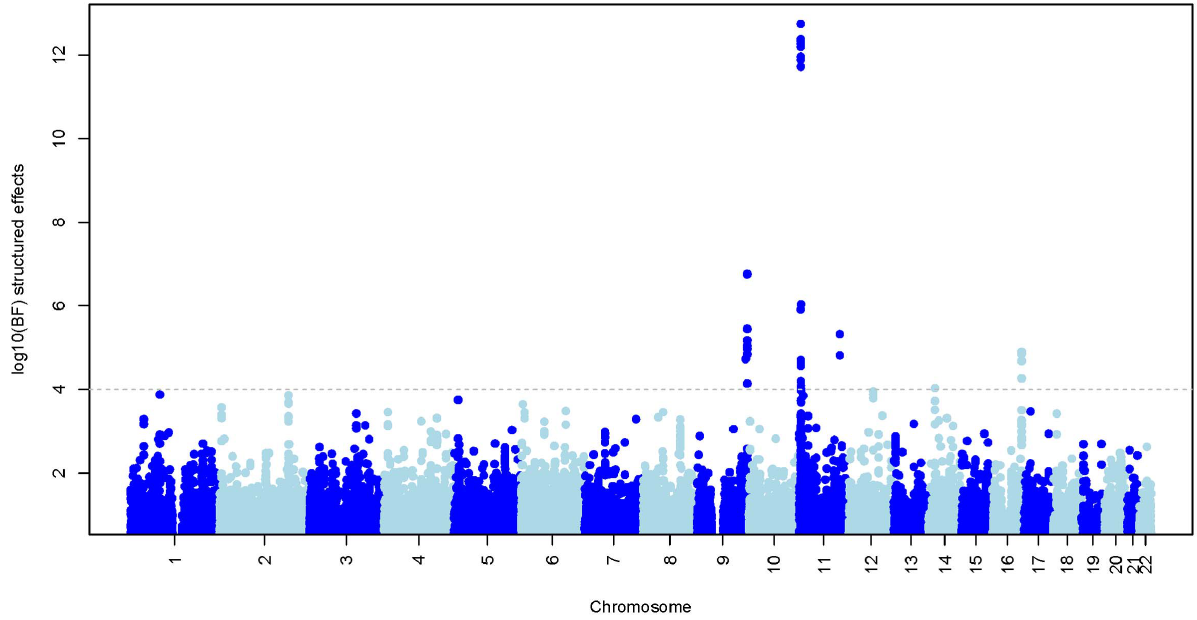
Figure 5. Evidence for association at approximately 1.3M autosomal SNPs. The plot shows the log10 Bayes factor comparing the structured effects model (model 4; see main text) to a model of no association. Chromosomes are coloured alternatively light and dark blue. The horizontal line indicates regions with strong evidence of association (BF . 1e4).